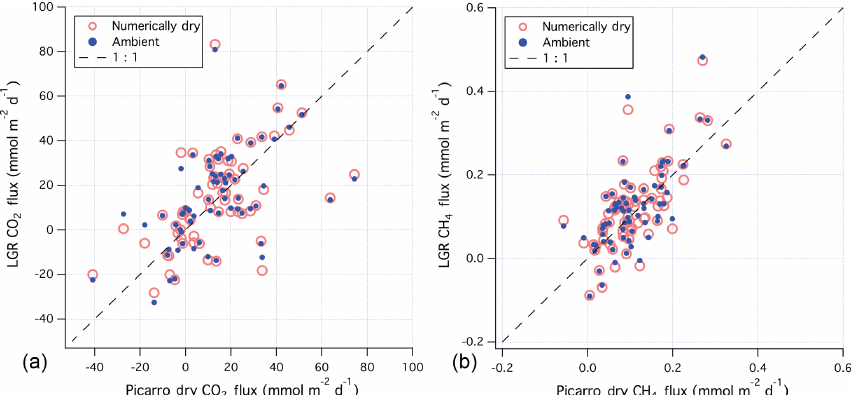
Figure 4. LGR (numerically dry and ambient) vs. Picarro (physically dry) CO 2 (left), and CH 4 (right) fluxes for the air–water wind sector of 45 to 80 ◦ . For CO 2 , rms error between the two instruments is 16.1mmolm − 2 day − 1 using numerically dry LGR data and 16.3mmolm − 2 day − 1 using ambient LGR data. For CH 4 , rms error between the two instruments is 0.063mmolm − 2 day − 1 using nu- merically dry LGR data and 0.064mmolm − 2 day − 1 using ambient LGR